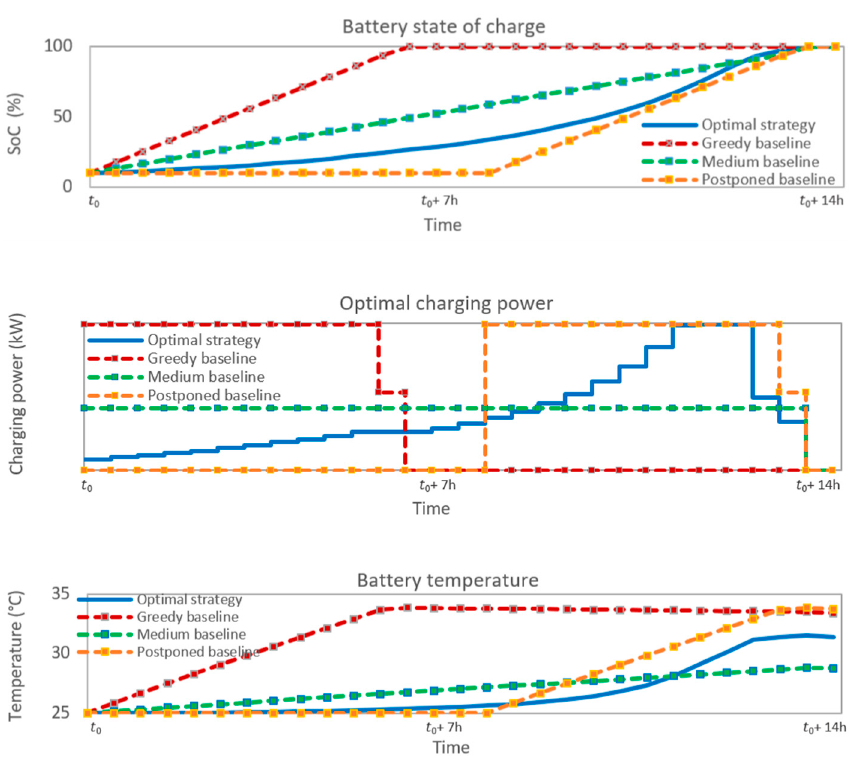
Figure 9. Optimal charging schedules compared with three typical charging strategies.